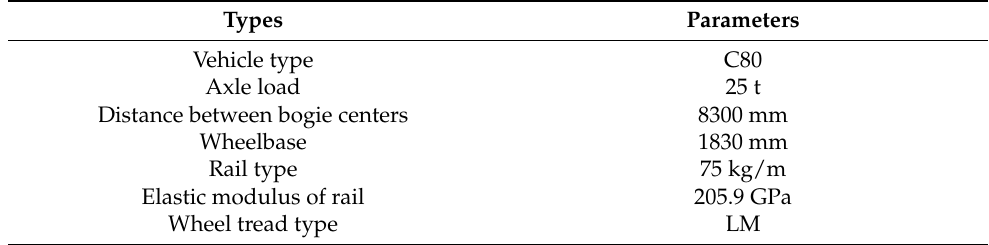
Table 3. Basic parameters of the